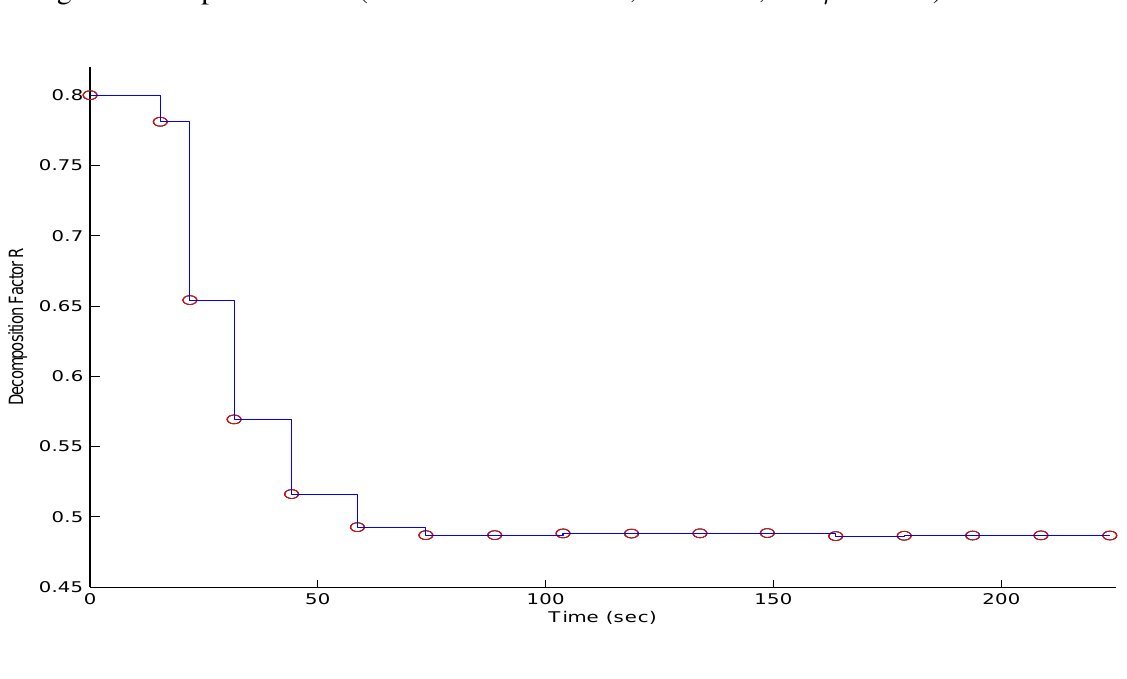
Figure 20 . QT-Decomposition factor R convergence over experimental time, under 10% congestion and packet losses(Initial values R = 0 : 8 , T d = 15 s, and (cid:22) = 0 : 01